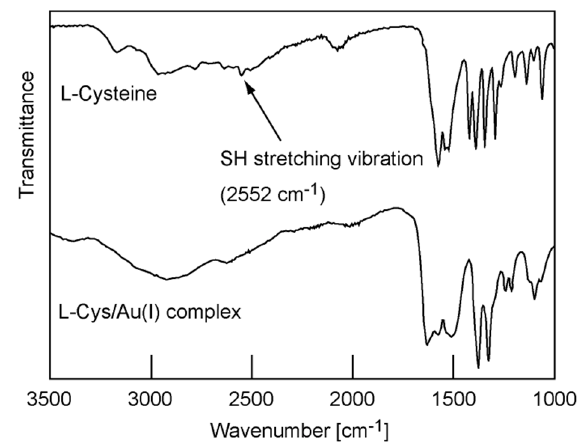
Figure 2. Image of the L-Cys/Au(I) complex without ( left ) and with ( right ) black light irradiation (wavelength 365 nm).